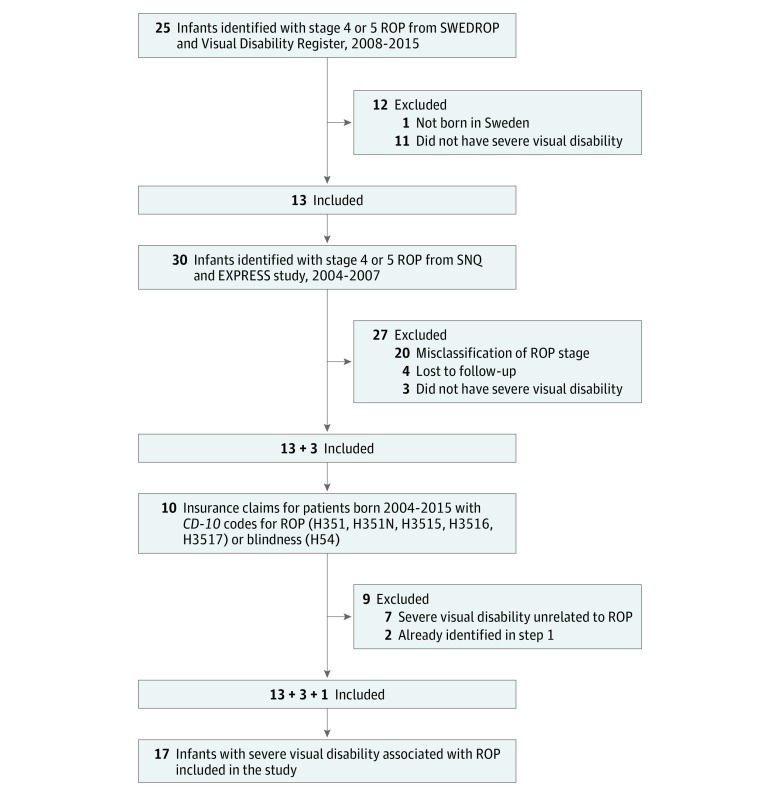
Flowchart of Participants EXPRESS indicates Extremely Preterm Infants in Sweden Study; ICD-10, International Classification of Diseases, Tenth Revision; ROP, retinopathy of prematurity; SNQ, Swedish Neonatal Quality Registry; SWEDROP, Swedish National Register for Retinopathy of Prematurity.